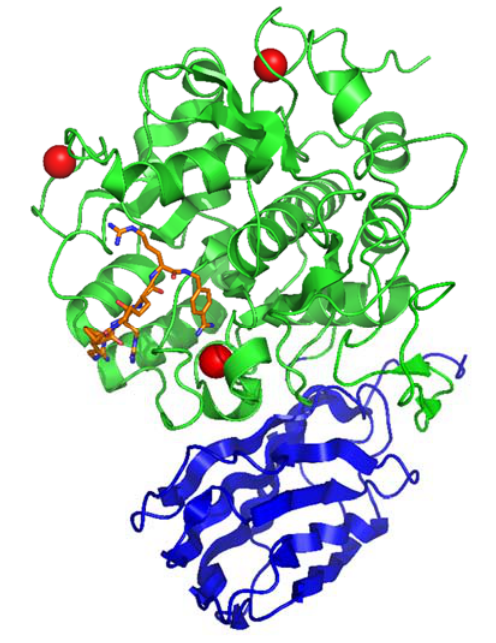
Figure 3. Structure of the soluble domain of human furin protein lacking the N-terminal propeptide (PDB ID: 6 hza). Furin was complexed with an artificial substrate-cyclic model peptide c[glutaryl-Arg-Arg-Lys]-Arg-4-Amba, which is shown as an orange colored stick model with blue nitrogens. Furin is a Ca 2 + -dependent endoprotease. In the structure, the Ca 2 + cations are shown as red spheres; Na + cations are shown as blue spheres; and the Cl - anion is shown as a yellow sphere. The furin’s catalytic domain is shown in green, and the P-domain is depicted in blue.